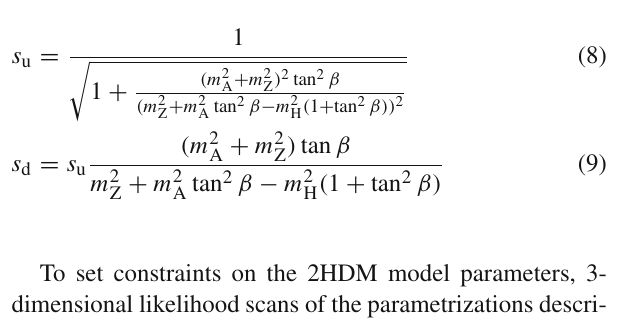
small values of m A , leading to the stronger